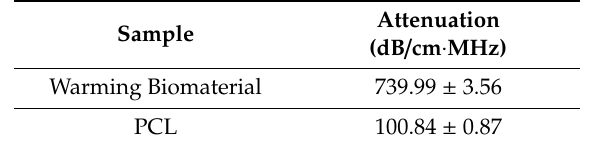
Table 1. Attenuation of warming biomaterial. PCL, polycaprolactone.